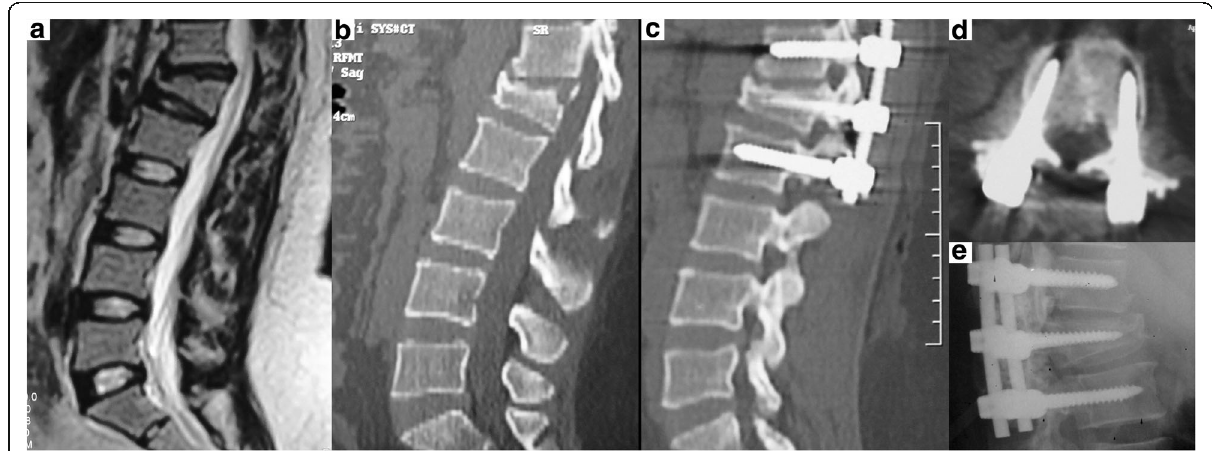
Fig. 1 a Pre-operative MRI sagittal view of the L1 fracture. b Pre-operative sagittal CT. c , d Post-operative CT. e Post-operative X-ray lateral